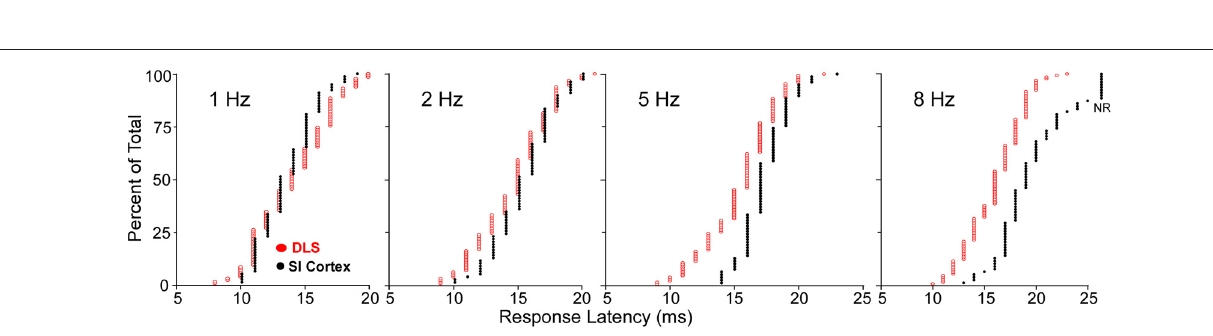
in response to rapid back-and-forth whisker deflections, neurons in SI respond only to the initial phase of the same back-and-forth whisker